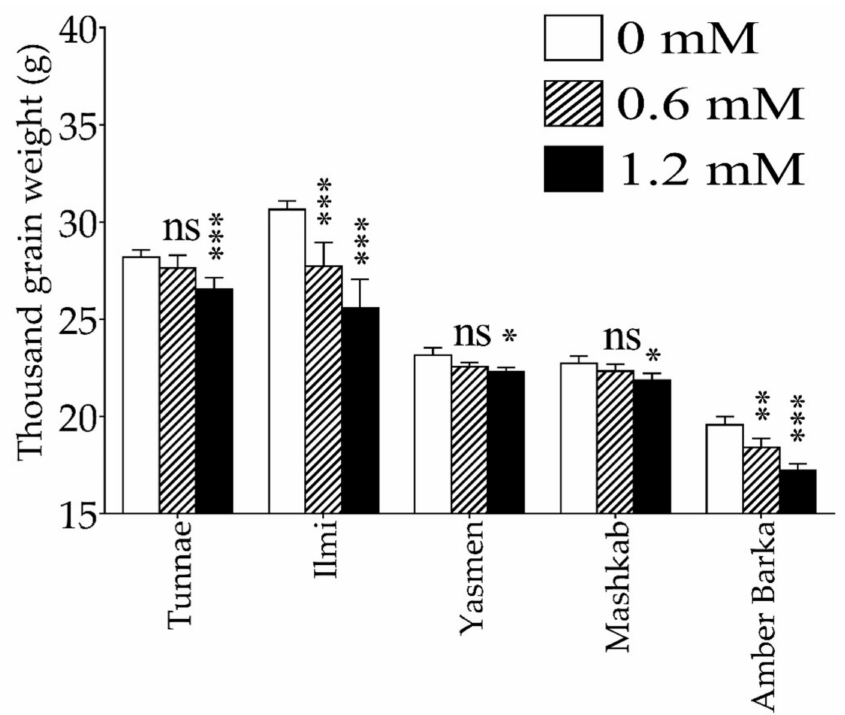
Figure 2. Changes in the grain weight of five rice cultivars in response to Pb application. The above graph shows the changes in thousand grain weight (TGW) in each of the five rice cultivars exposed to lead (Pb) stress. Cultivars are Tunnae, Ilmi, Yasmen, Mashkab, and Amber Barka. Bars are mean values ± SE. Data were compared to the control (0 mM Pb). *** p < 0.001, ** p < 0.01, * p < 0.05, ns :